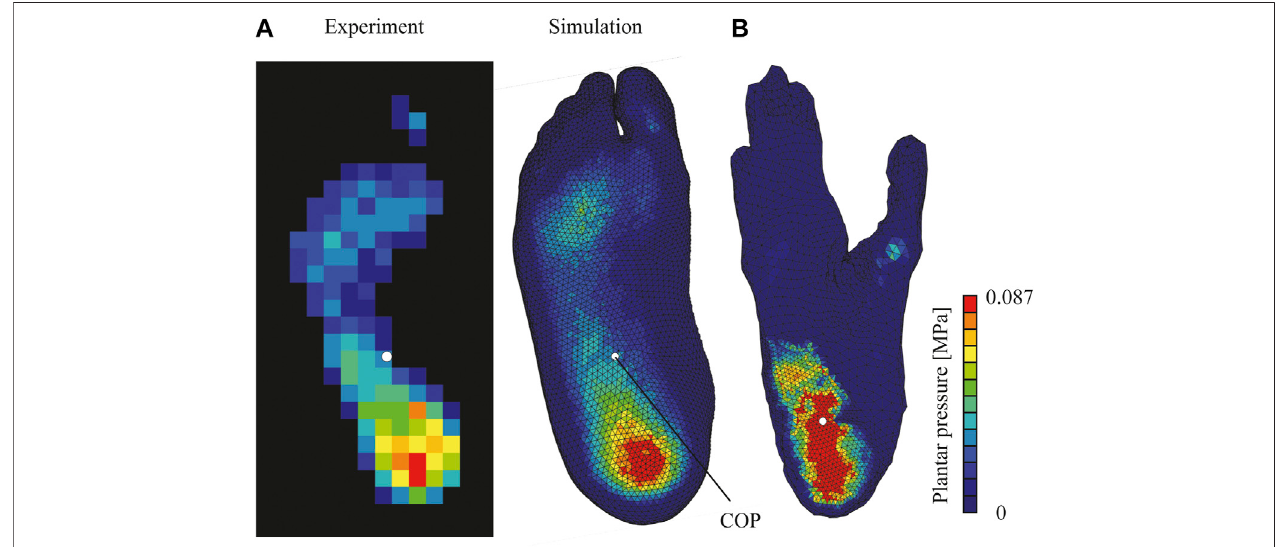
FIGURE3| Plantarpressuredistributionsofhuman (A) andchimpanzee (B) feetduring simulatedquiet standing. Calculatedcenter ofpressure(COP) depictedas white circle. Experimentally measured plantar pressure distribution of human during quiet standing presented for comparison.